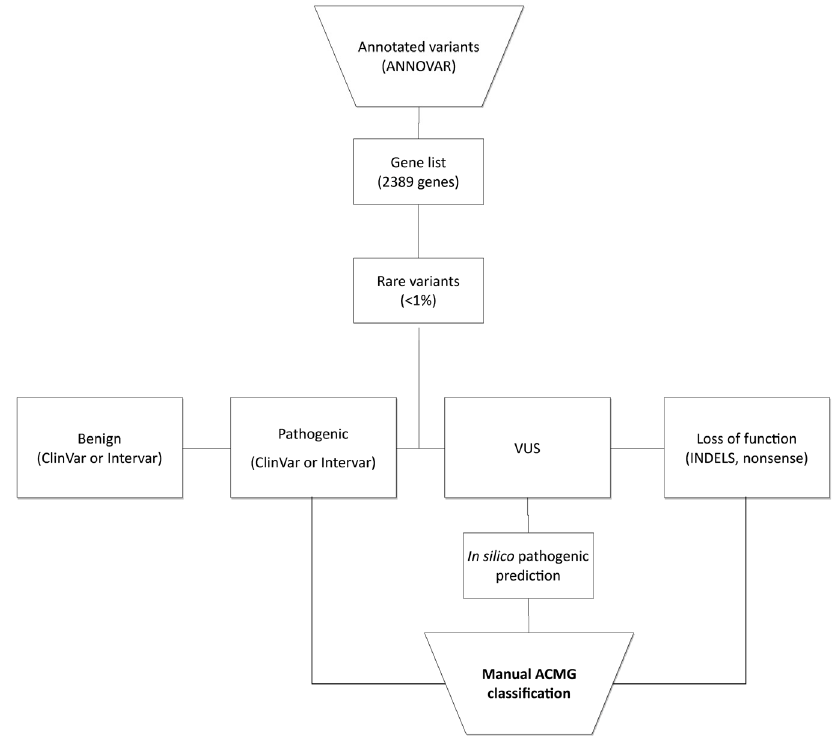
Figure 2. Flowchart of decision process for variant prioritization.